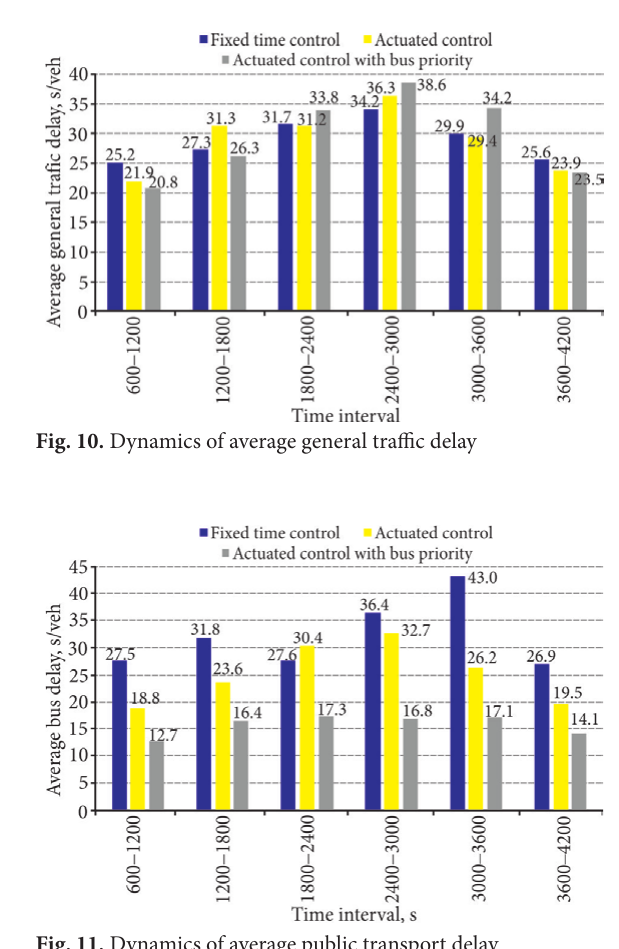
Fig. 11. Dynamics of average public transport